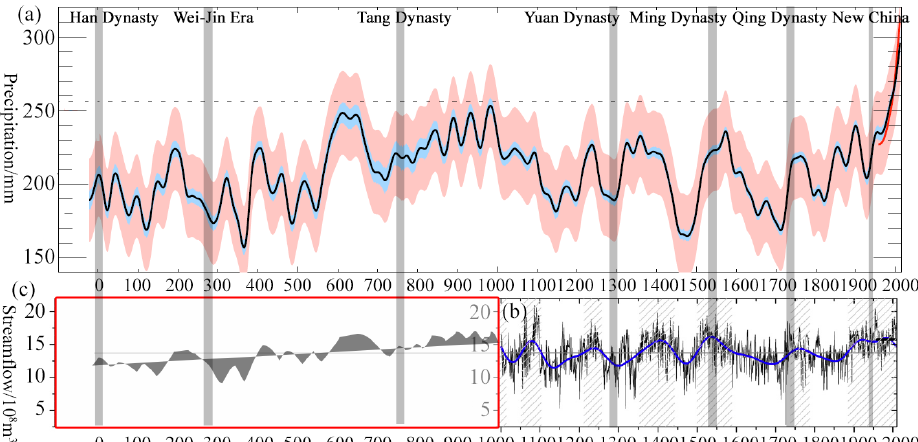
Figure 3. (a) Yang et al.’s (2014) annual precipitation reconstruction for the Qilian Mountains over the last 2000 years, with 50year smooth- ing. (b) Qin et al.’s (2010) annual streamflow reconstruction spanning the last millennium with 50year smoothing at YLX. (c) Our extension of the streamflow from 0 to AD1000 based on the Yang et al. (2014) precipitation reconstruction and the Qin et al. (2010) streamflow